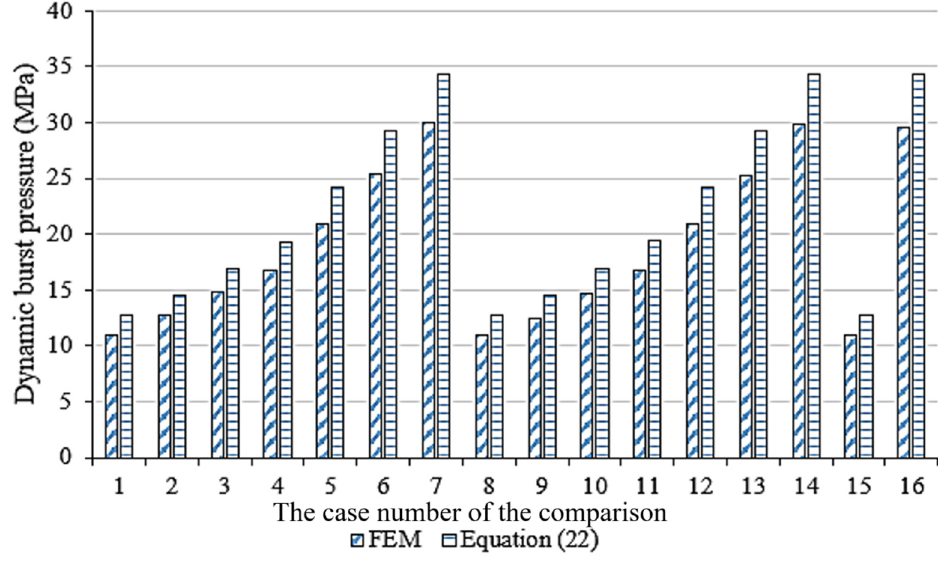
Figure 7. Comparisons between the FEM results and Equation (22), when t d = 39 ms.